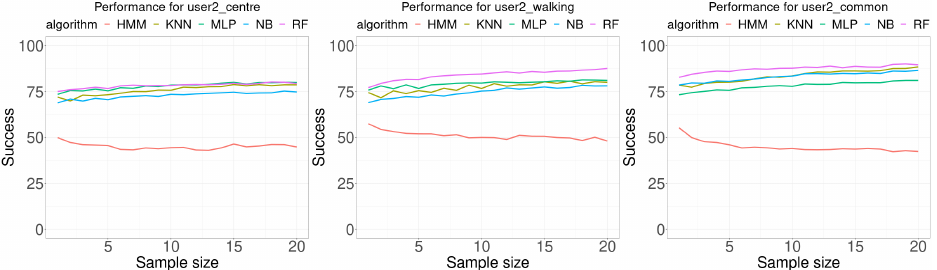
Figure 8. Performance comparison for user 2. Each curve plots the successful rate (percentage) as a function of the number of consecutive samples used for classification (sample size). Each Wi-Fi database contained 100 samples per room for building the model.